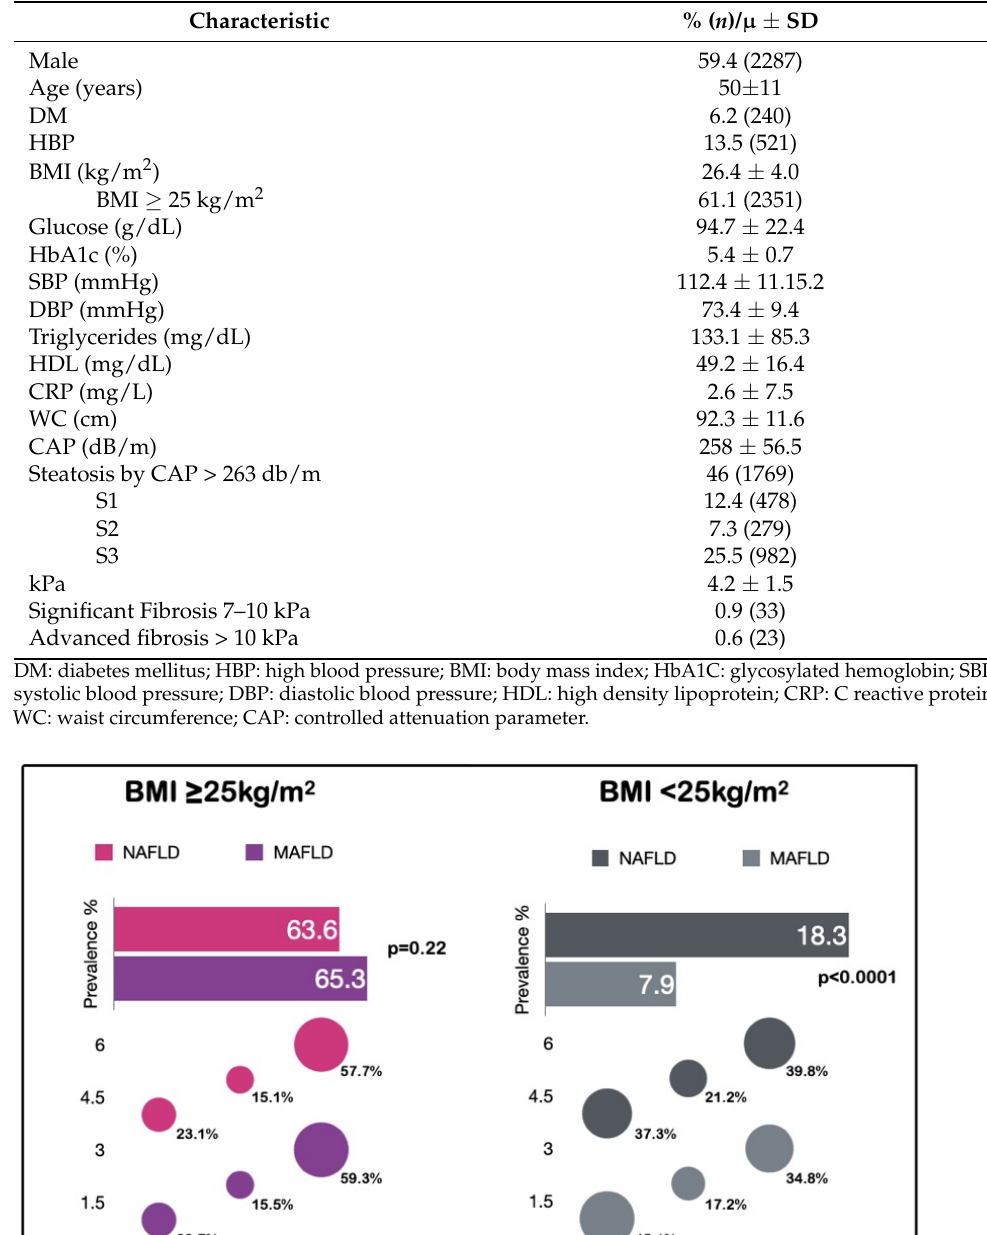
Table 1. Clinical and demographic characteristics of all patients ( n = 3847).